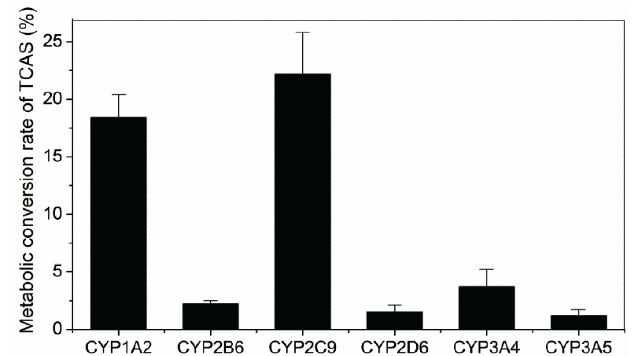
Figure 1. Metabolic conversion rate of TCAS in cDNA-expressed P450 enzymes. Values are presented as M ± SD (n = 3).